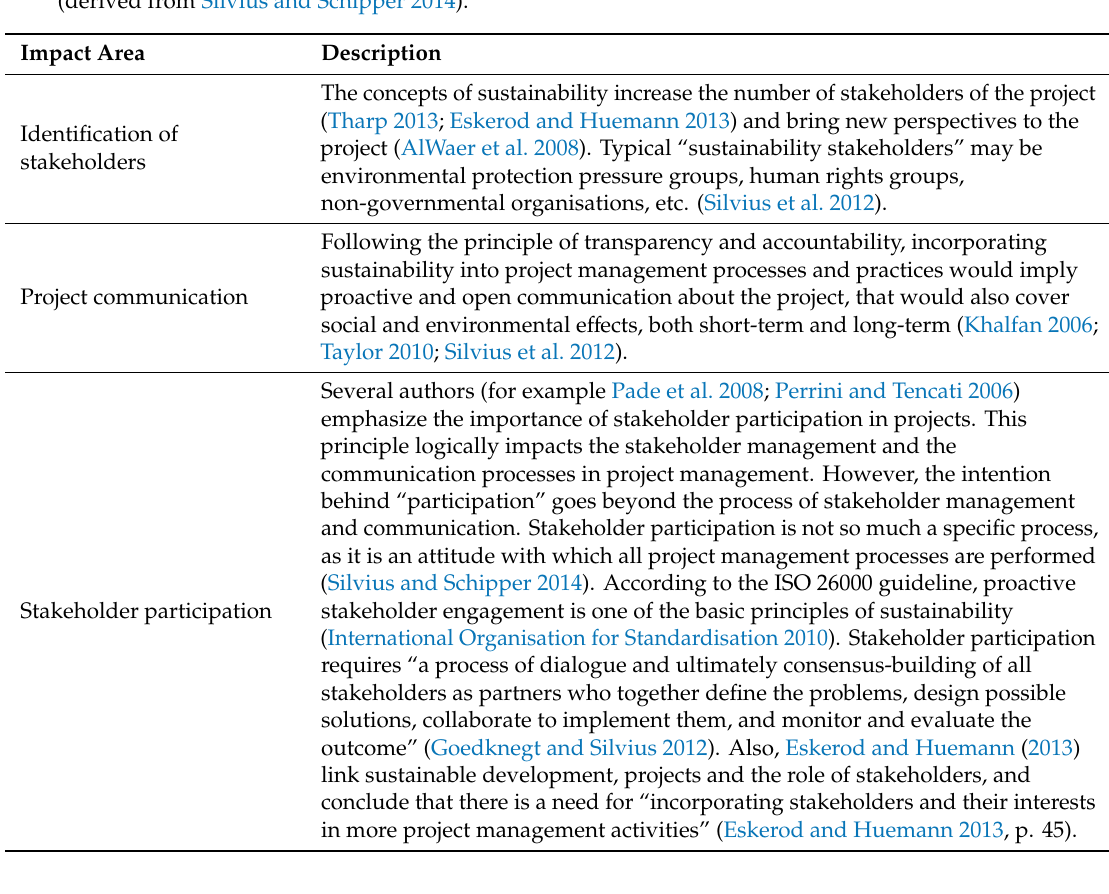
Table 2. Project stakeholder management related impact areas of sustainability on project management (derived from Silvius and Schipper